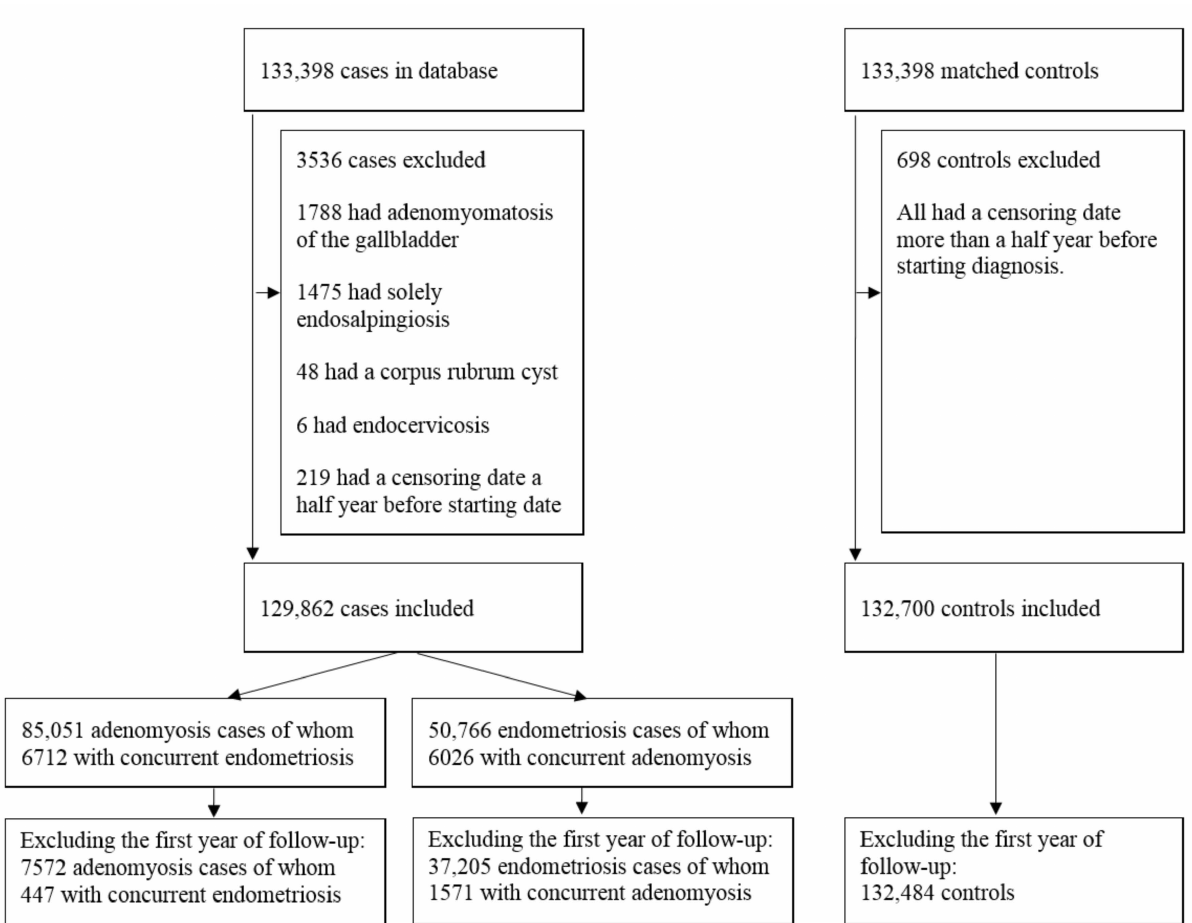
Figure 1. Consort flow diagram of the study population of cases and